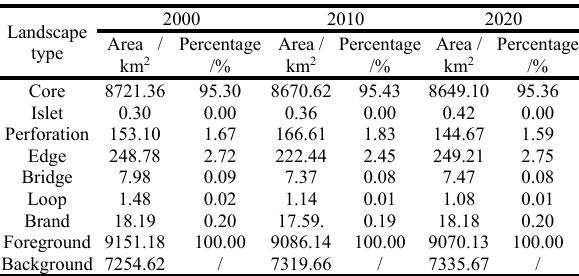
Table 3 . Change in area and proportion of MSPA class from